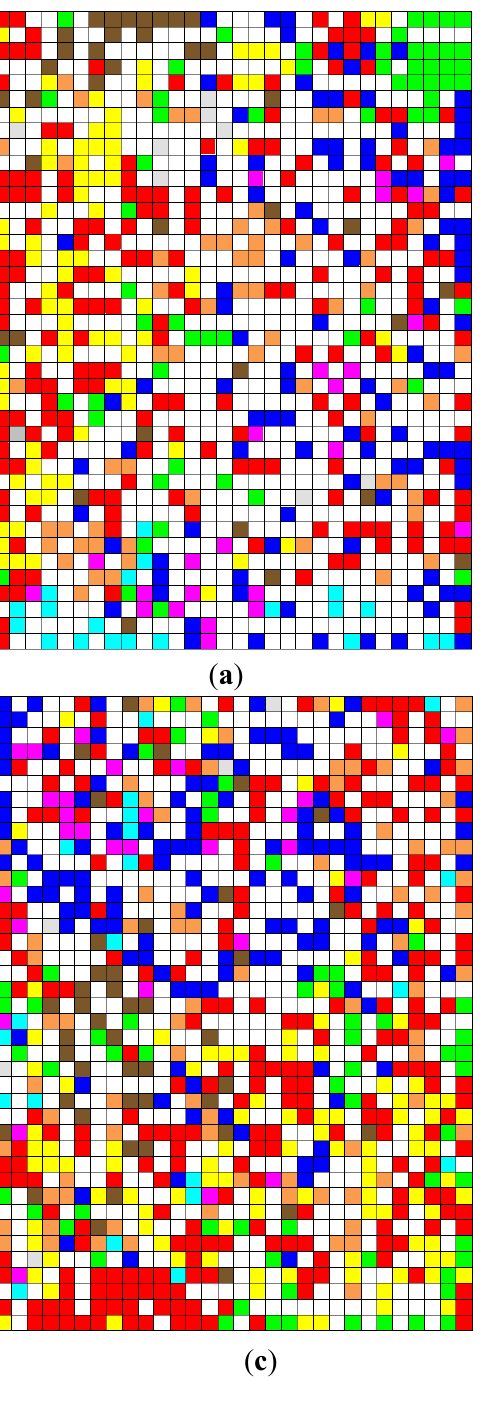
Figure 3. Self-organising maps obtained by classifying nine tribes of the Asteraceae family. Maps: ( a ) Using the block of atom-centred descriptors; ( b ) Using the block of BCUT descriptors; ( c ) Using the block of RDF (Radial Function Distribution) descriptors; ( d ) Using the block of 3D MoRSE